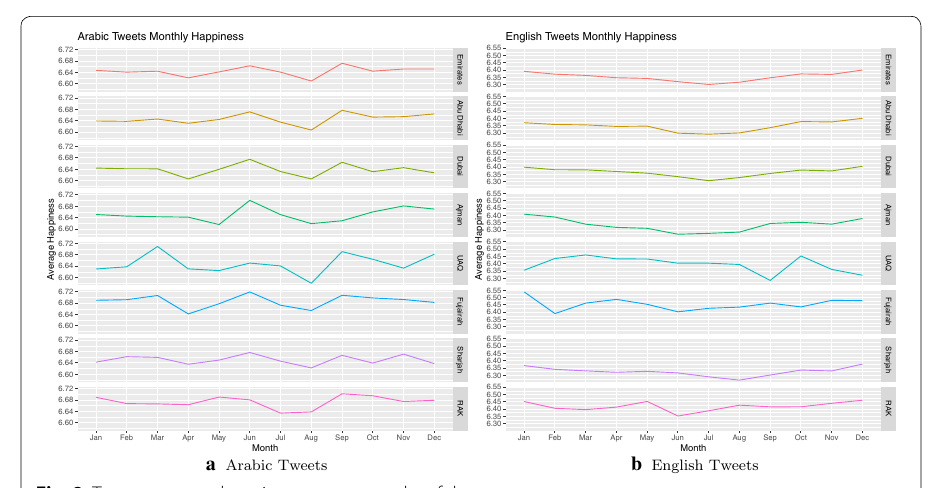
Fig. 8 Tweets average happiness across months of the